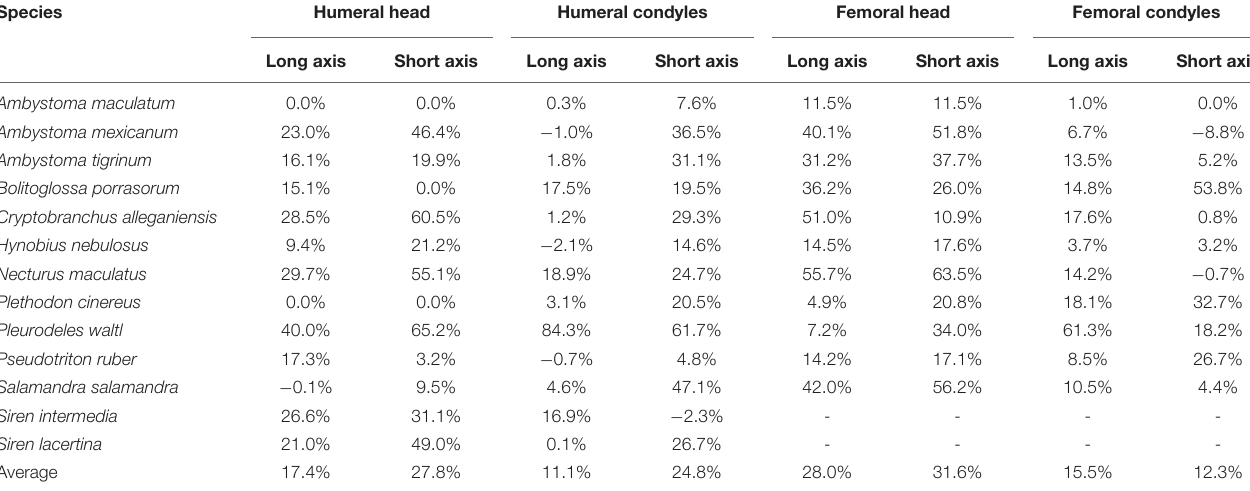
FIGURE 5 | Ancestor reconstruction of cartilage correction factors using maximum parsimony. Time calibrated phylogeny from Timetree.org (Hedges et al., 2006). A test for phylogenetic signal in the data was non-significant (Blomberg’s K = 0.271, p = 0.355). See SI for individual ancestor reconstructions on cartilage correction factors in the humerus, femur, radius, ulna, tibia, and fibula. TABLE 4 | Dimensions of cartilaginous epiphyses compared to mineralized epiphyses. Values represent the percentage increase in long and short axes of the cartilaginous epiphyses over the mineralized